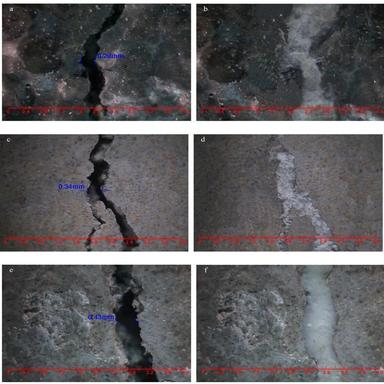
Surface crack self-healing of mortars containing different microcapsules. (a) AM1 before self-healing, (b) AM1 for 4 h self-healing, (c) AM2 before self-healing, (d) AM2 for 4 h self-healing, (e) AM3 before self-healing, (f) AM3 for 4 h self-healing.